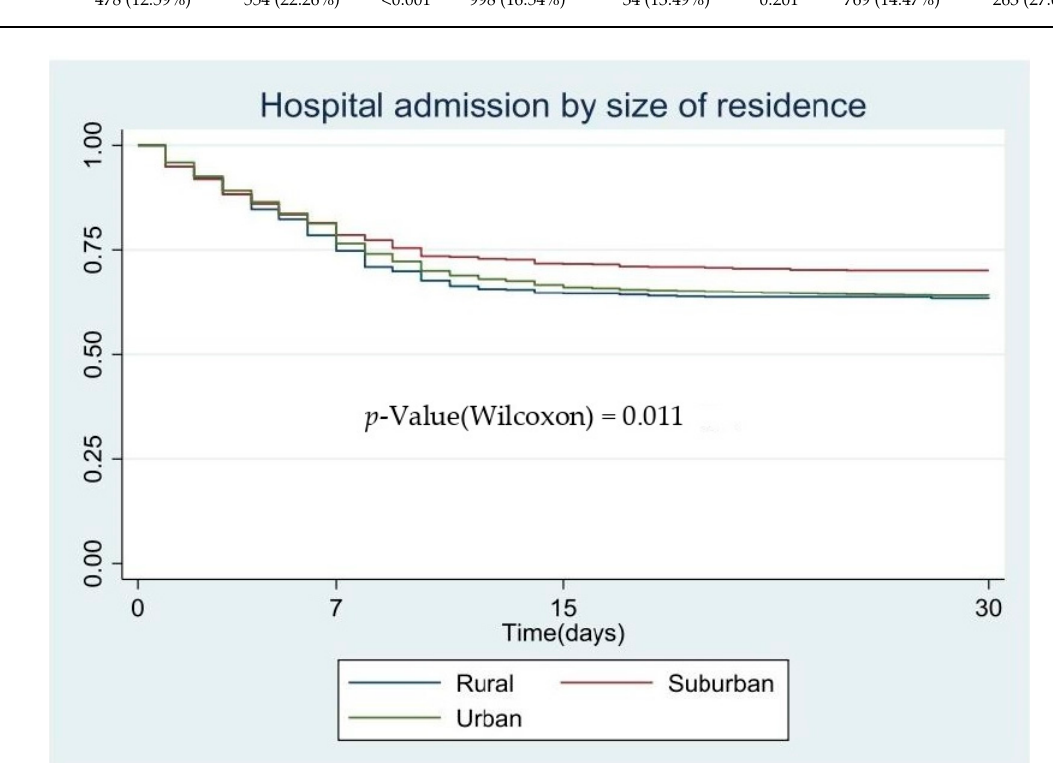
Figure 2. ICU admission by size of residence, Kaplan–Meier survival.